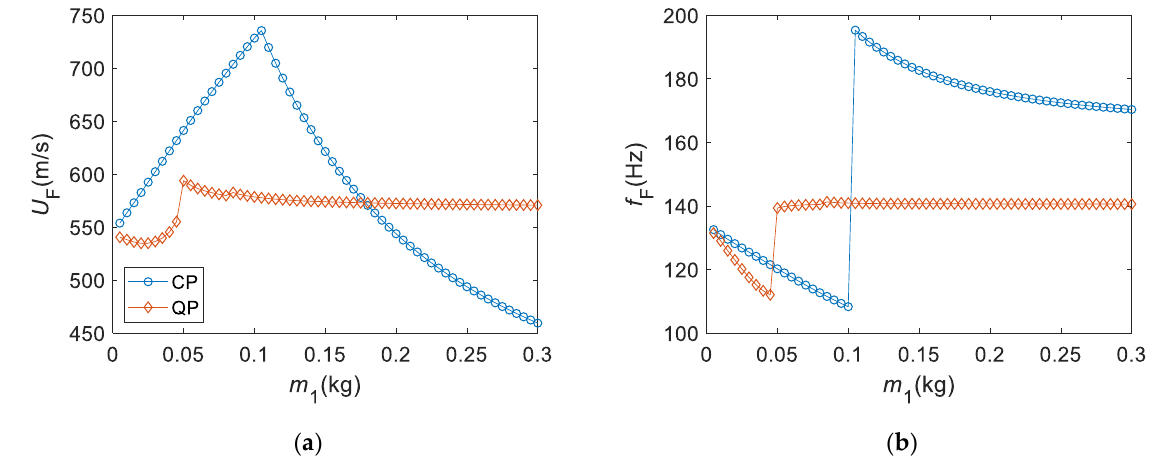
Figure 10. The changes in flutter characteristics caused by the change in attachment mass: ( a ) flutter